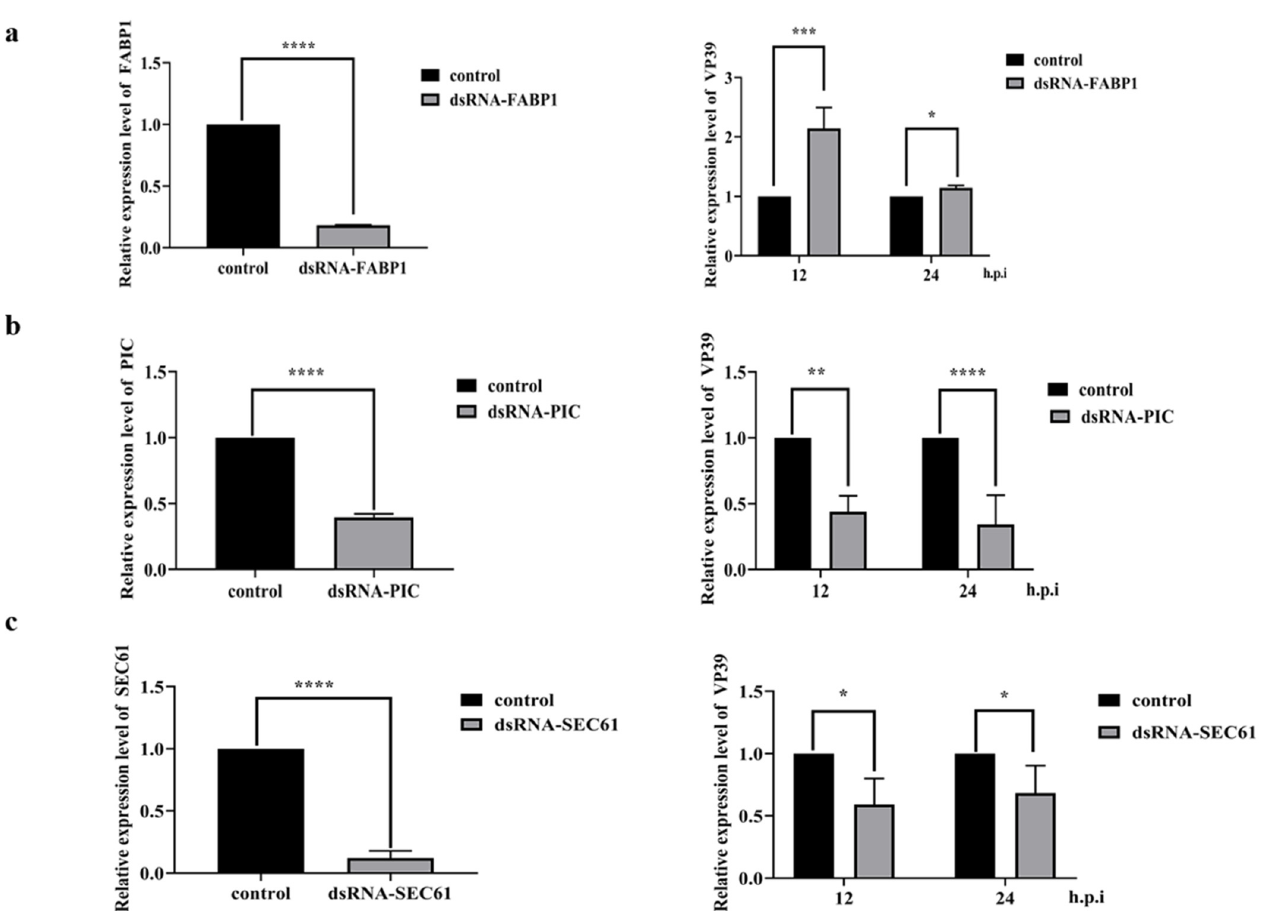
Figure 8. Effects of FABP1, PIC, and SEC61 on the proliferation of BmNPV. ( a ) The RNAi of the dsRNA-FABP decreases the expression level of FABP1 in a dose-dependent manner at 24 h ( p < 0.0001), The dsRNA-EGFP is transfected as the control. Relative expression levels of the VP39 in the dsRNA-FABP1 transfected BmN cells at 12 h.p.i ( p < 0.001) and 24 h.p.i ( p < 0.05) by the